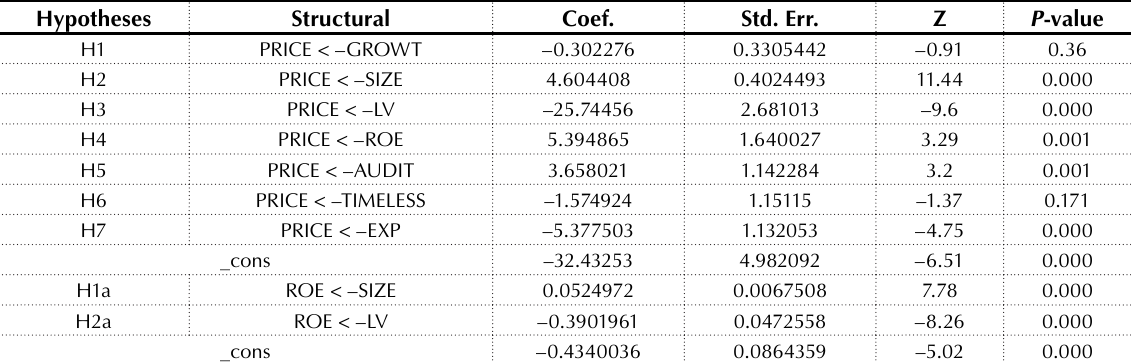
Table 6. Multivariate regression with dependent variable of stock price